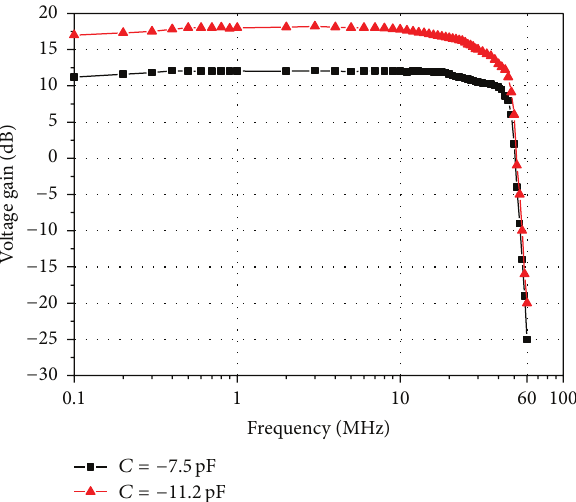
Figure 7: 𝑆 -parameters of the low-pass filter.